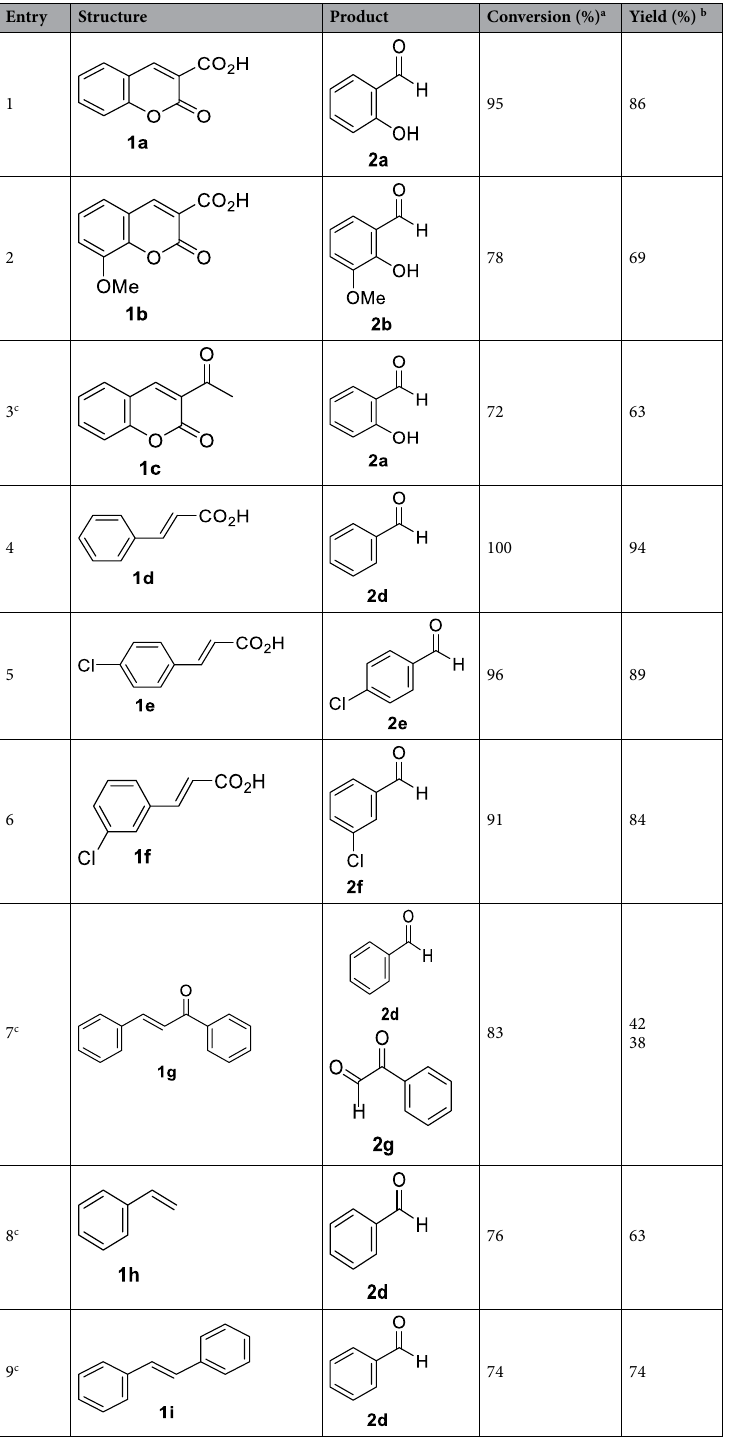
Table 3. Oxidative cleavage of alkenes to corresponding aldehydes in the presence of A-CQDs/W catalyst. Reaction conditions: Substrate (1 mmol), H 2 O 2 (3 mmol), H 2 O (1.5 mL), A-CQDs/W (1 mol %), 3 h, 90 °C. b Conversions were calculated based on initial mmol of substrate. c Isolated Yields. d In the presence of 0.25 mmol CH 3